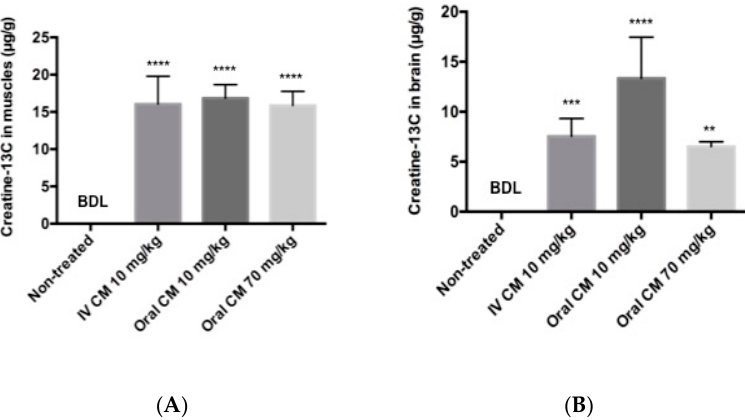
Figure 4. ( A ) Muscle and ( B ) brain concentrations of Creatine- 13 C 4 h after administration of CM- 13 C. Values represent the mean ± SEM. Creatine- 13 C content in muscle and brain samples from non-treated rats was below detection limits (0.5 μ g/g tissue). n = 4 rats. ** p < 0.01, *** p < 0.001, **** p < 0.0001 compared to levels in non-treated group. BDL = below detection limit.